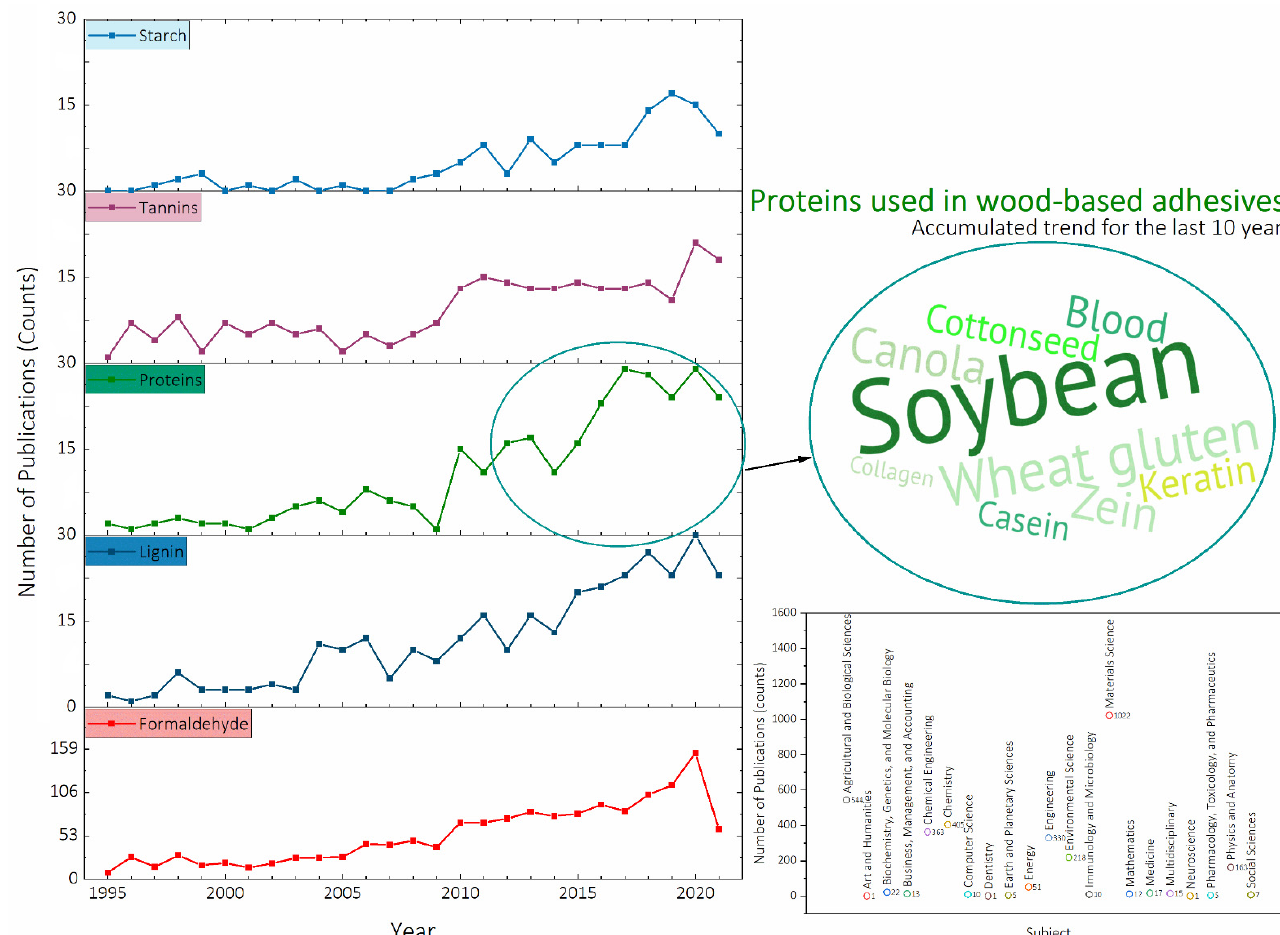
Figure 1. Distribution of the number of publications indexed in the Scopus database.